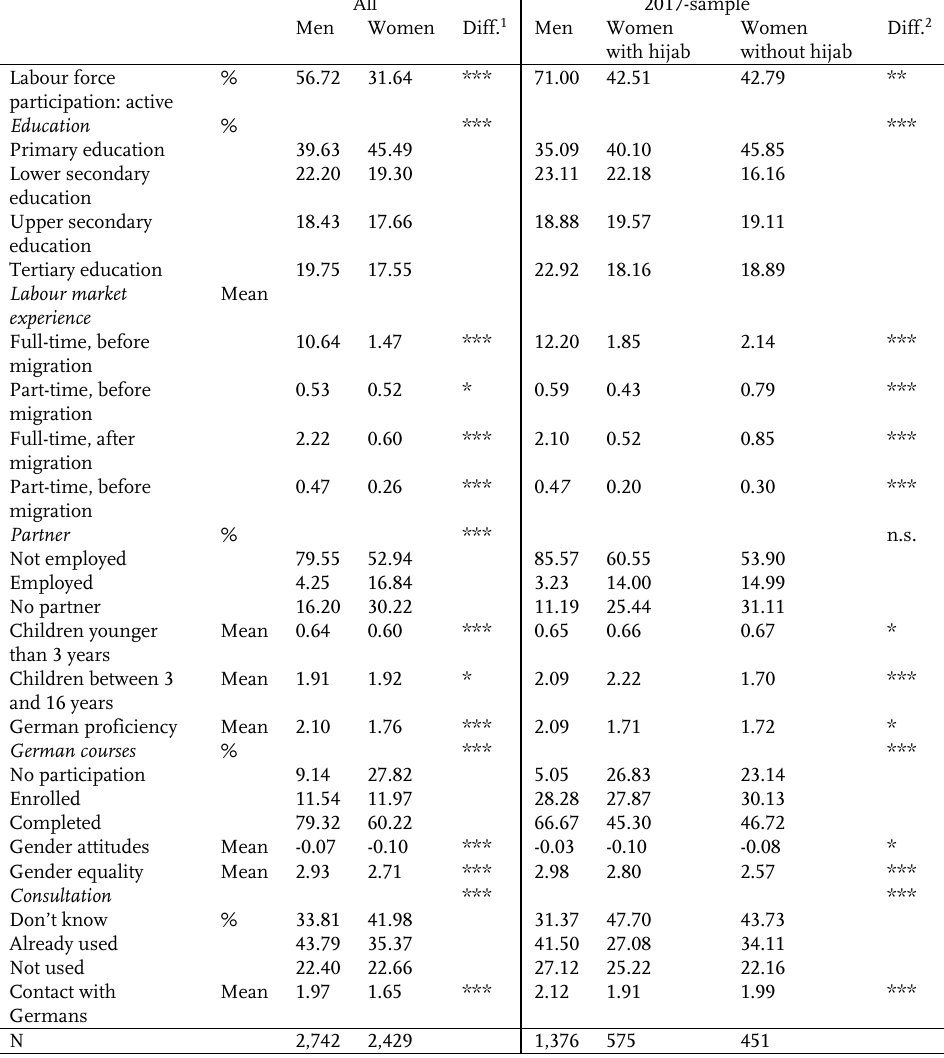
Table 1 : Descriptive statistics for analytical samples